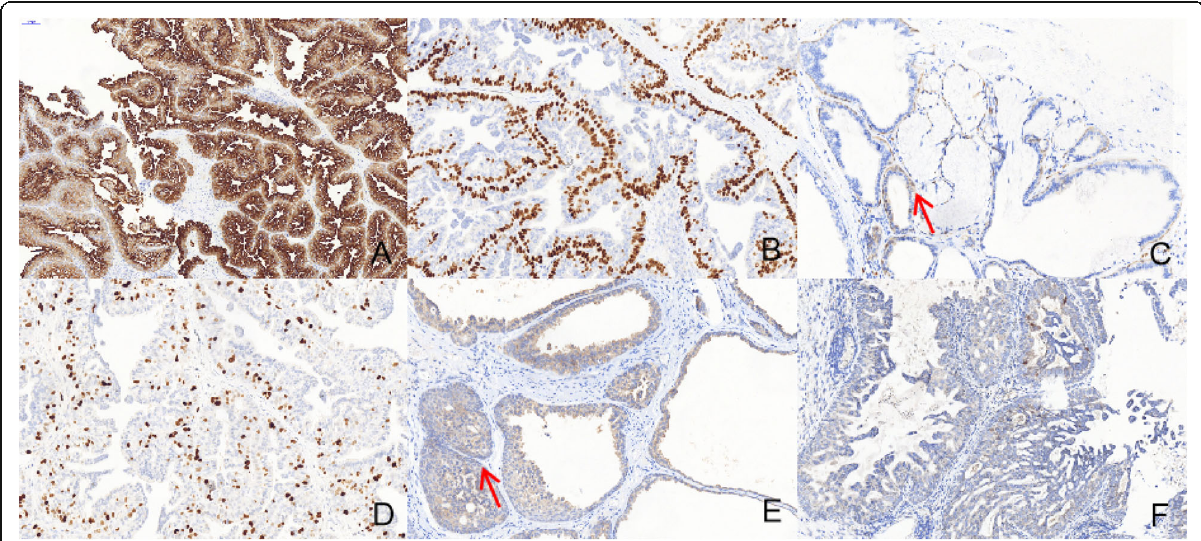
Fig. 4 Immunohistochemical performance of Pathological manifestations. a CK7 is strongly positive in the luminal cells (100x). b p63 shows strong positive staining in the basal cells (100x). c S-100 shows positive staining in the basal cells (Red arrow) (100x). d Ki67 ranges from 20 to 30% (100x). e The expression of BRAF V600E is observed in both the glandular and squamous components (Red arrow) (100x). f BRAF V600E immunohistochemistry in the third case shows a weak staining (100x)